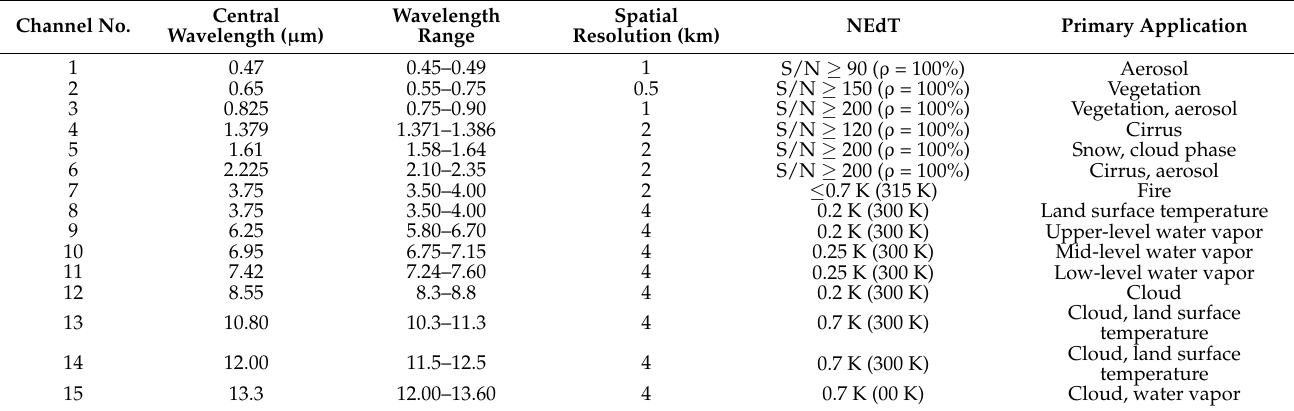
Table 1. Characteristics of